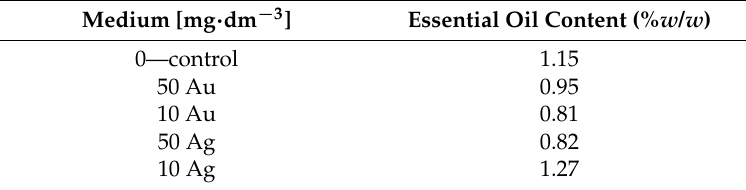
Table 1. Essential oil content in lavender plants as a function of medium used.